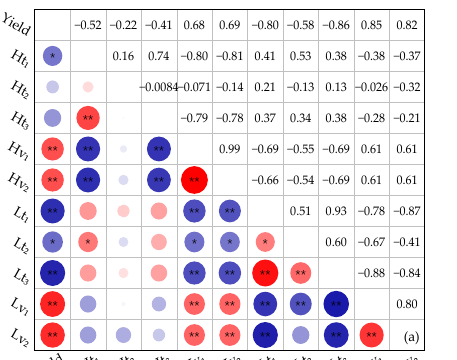
Figure 8. Correlation coefficients between the logistic ( a ) and Richards ( b ) characteristic parameters of model and yield . * and ** identify significant differences at p < 0.05 and p < 0.01, respectively. The stepwise regression method was used to establish the optimal regression